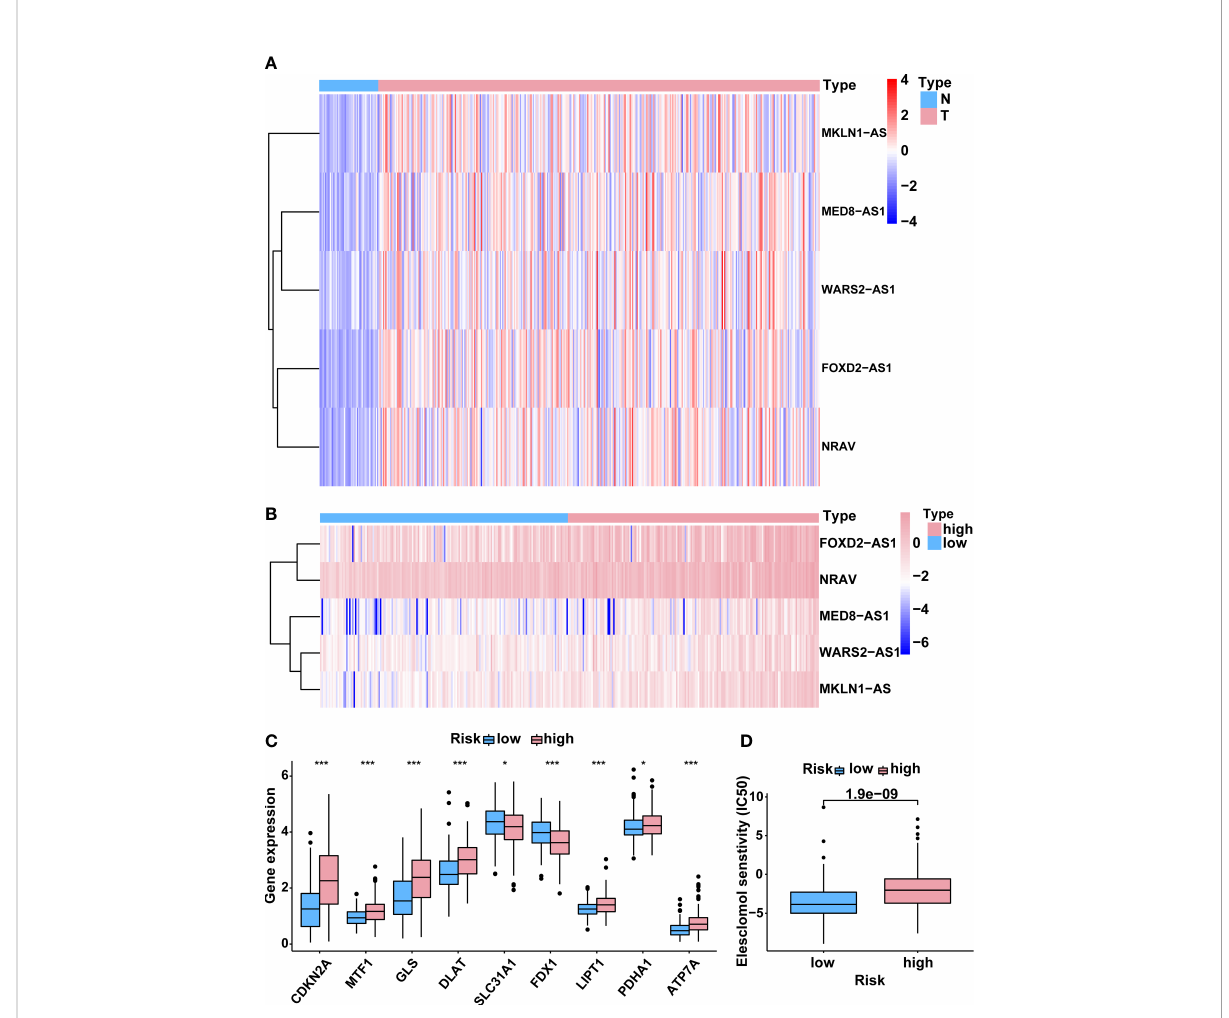
FIGURE 6 Correlation between the predictive signature and cuproptosis. (A) The expression levels of 5 lncRNAs associated with cuproptosis in HCC and normal tissues. (B) The expression levels of 5 cuproptosis-related lncRNAs in groups with low and high risk. (C) The differential expression levels of CRGs between high- and low-risk groups. (D) Comparison of senstivity of cuproptosis inducer elesclomol between high- and low-risk groups. lncRNAs, long noncoding RNAs; HCC, hepatocellular carcinoma; CRGs, cuproptosis-related genes. *p < 0.05, and ***p <